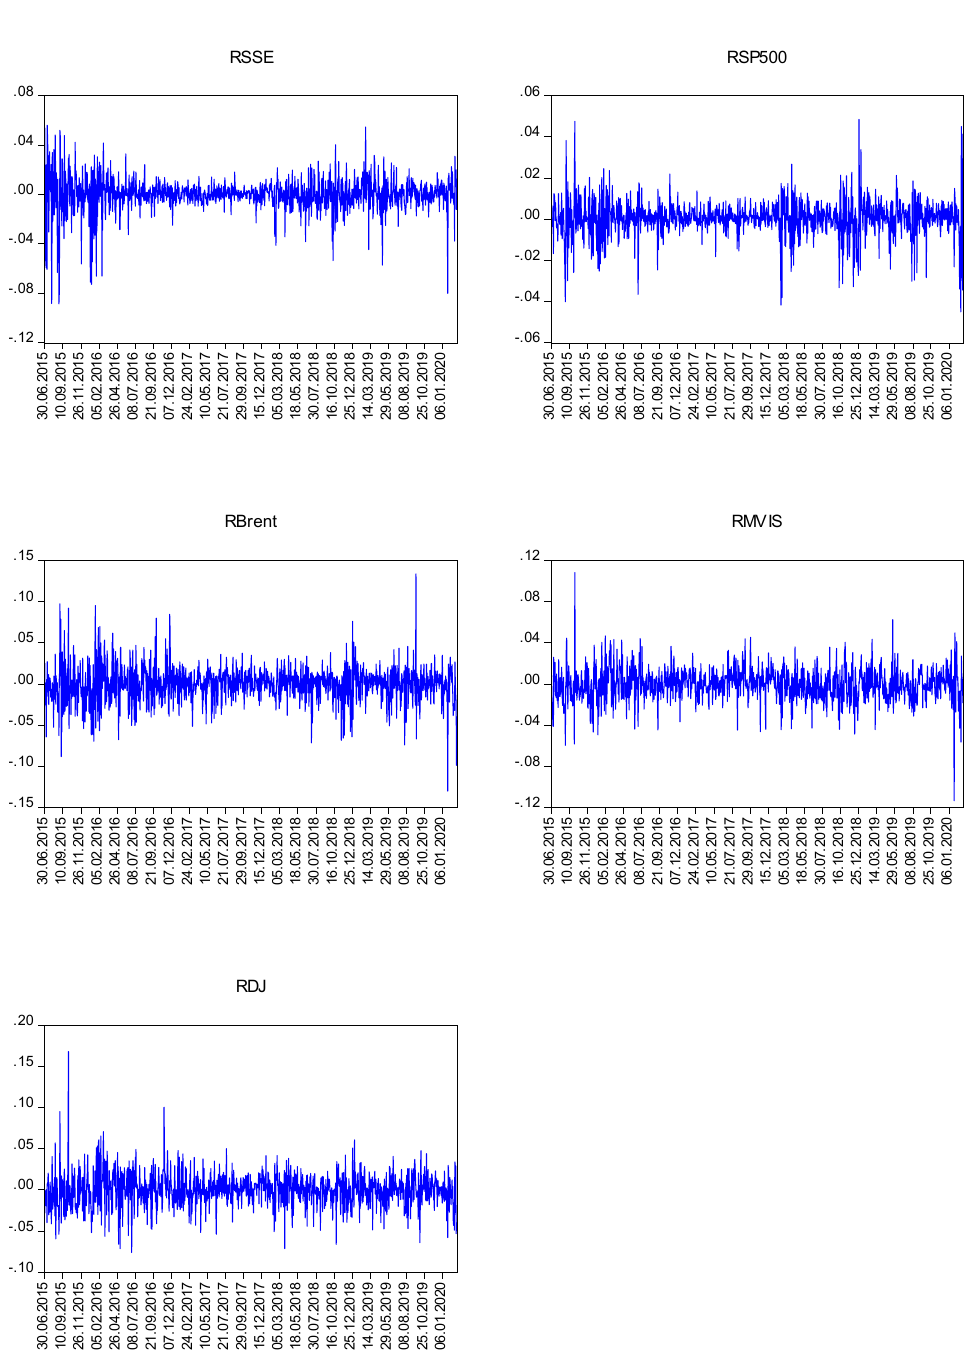
Figure 2. Daily returns of SSE, SP500, Brent, MVIS, and DJI.